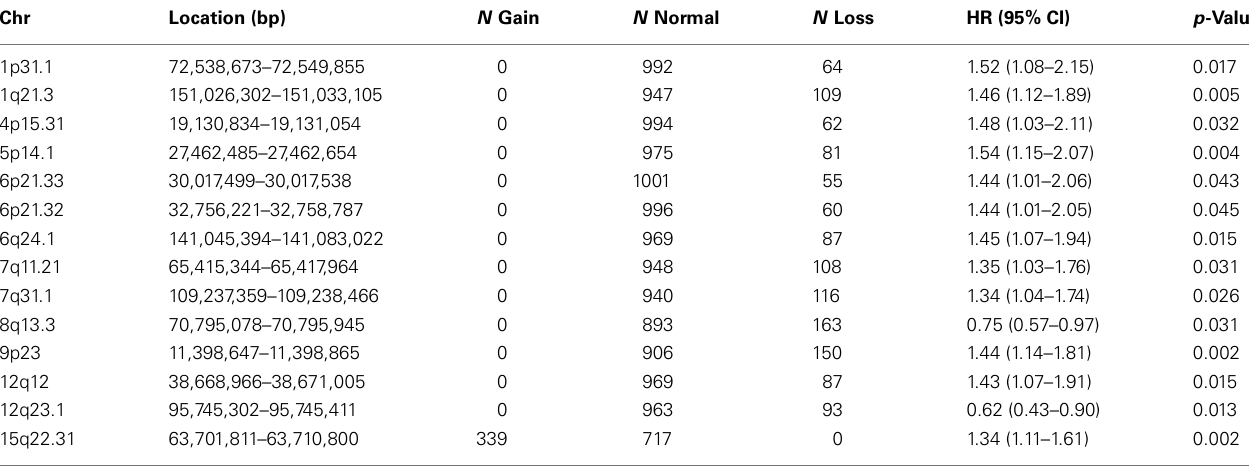
HR, hazard ratio; CI, confidence interval adjusted for study site, age at diagnosis, and first two population structure principal components. The start and end point based on the minimum common region determined from R package cghMCR (Aguirre et al., 2004), genomic build 36; normal number of copies is the reference